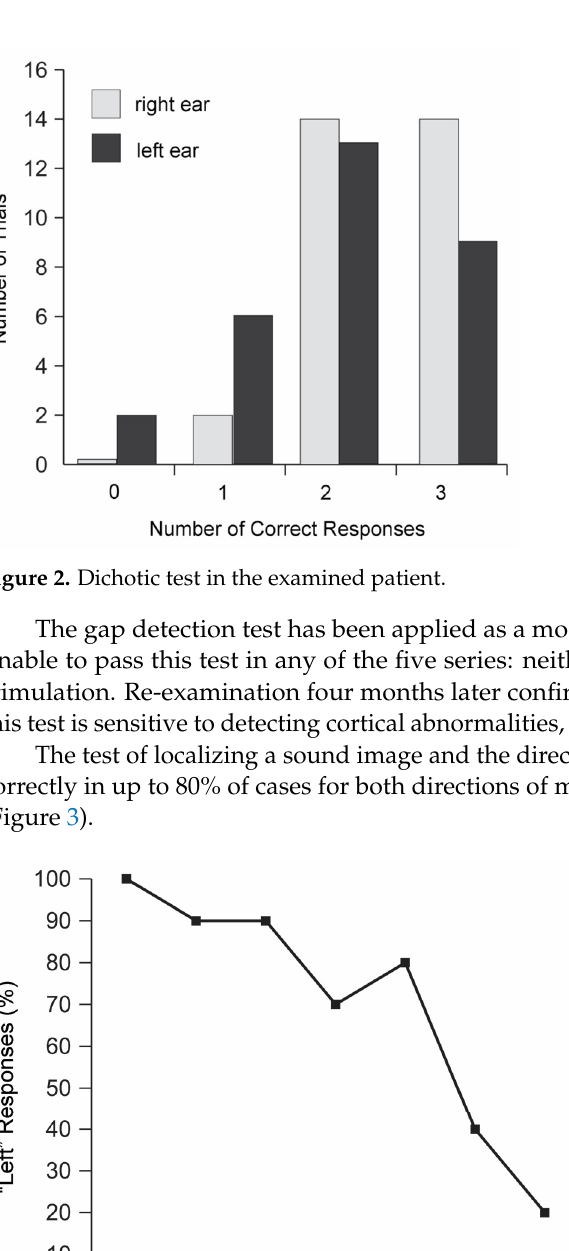
Figure 4. Corneal confocal microscopy with the assessment of the subbasal plexus.